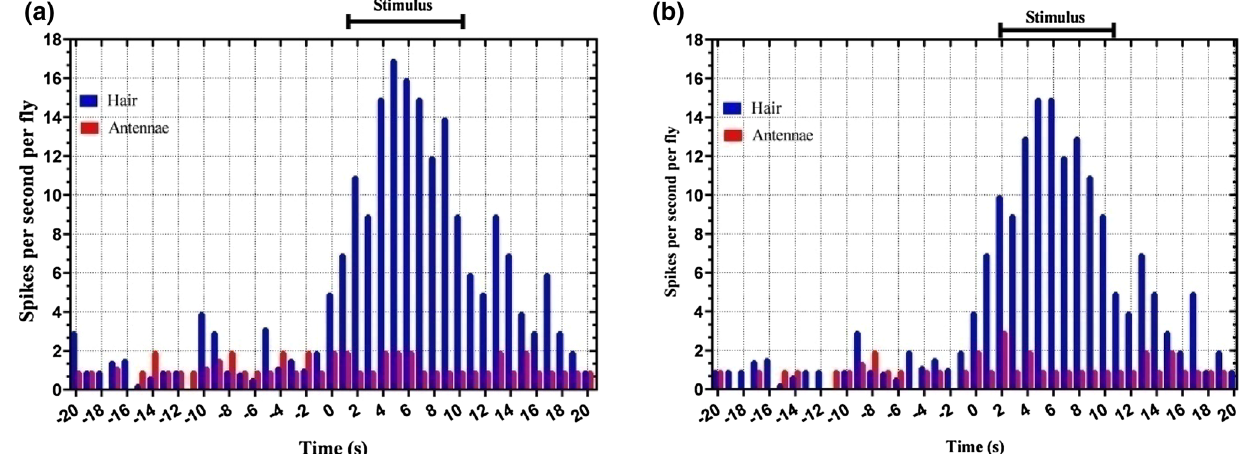
Figure 4. ( a ) The electrophysiological response of antennae (red) and hairs (blue) of Cheilosia albipila to a weak electric field applied. The graph indicates the change in rate of firing of nerves of antennae and the hairs to a weak electric field stimulus applied and the blue lines indicate the stimulus. ( b ) The electrophysiological response of antennae (red) and hairs (blue) of Eristalis tenax to a weak electric field applied. The graph indicates the change in rate of firing rate of nerves of antennae and the hairs to an electric field stimulus applied and the blue lines indicate the stimulus. The bars represent the numbers of spikes per second per